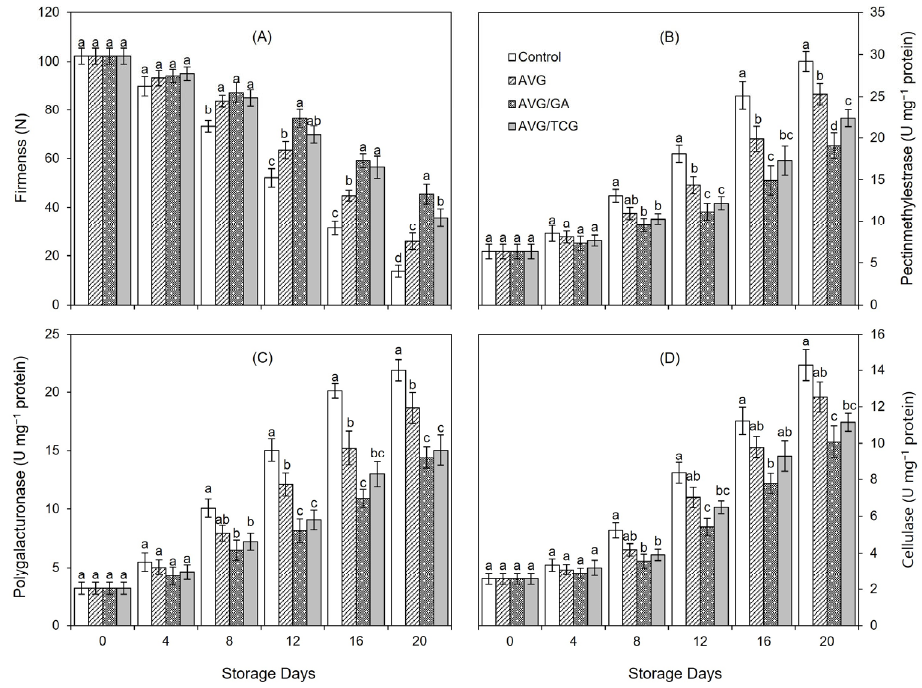
Figure 7. Effect of AVG ‐ based composite coatings on firmness ( A ), pectin methylesterase activity ( B ), polygalacturonase activity ( C ) and cellulase activity ( D ) of persimmon fruits during 20 days storage (analysis on day 0, 4, 8, 12, 16 and 20) at 20 ± 1 °C and 80–85% relative humidity. All standard error bars are centered on means (3 biological replicates). Graph bars sharing same letters on a storage interval have non ‐ significance difference according to the LSD test at p ≤ 0.05.